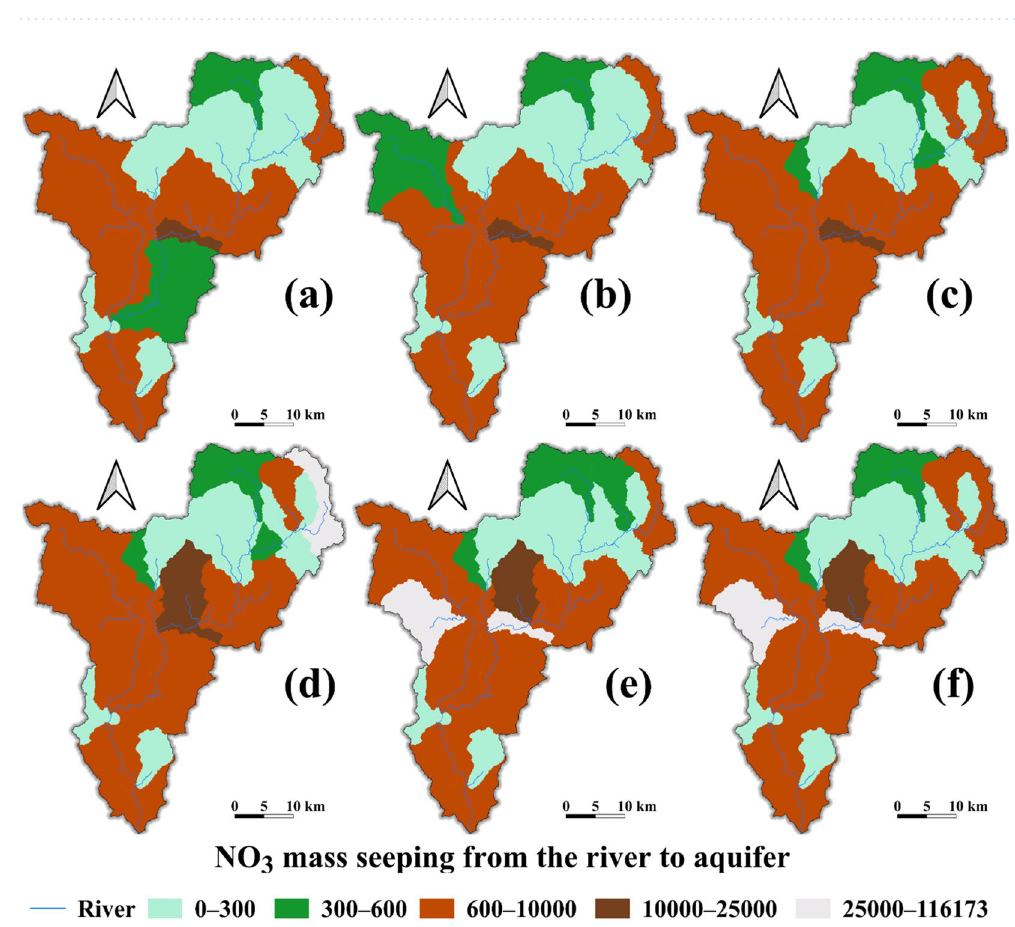
Figure 13. Spatial distribution of nitrate (NO3) seepage (Kg/day) from the river to the aquifer: ( a ) baseline, ( b ) scenario 1, ( c ) scenario 2, ( d ) scenario 3, ( e ) Scenario 4, and ( f ) Scenario